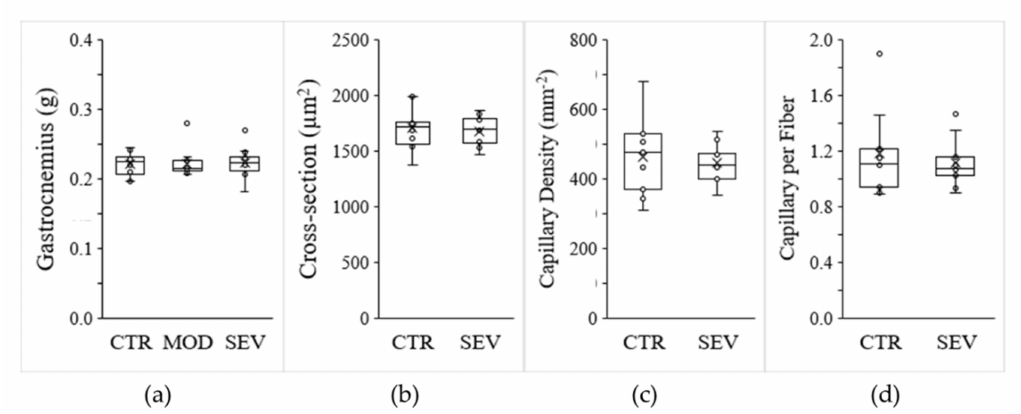
Figure 3. Mg 2+ -deficient diet and muscle characteristics. Mice were fed either a control (CTR), a mildly (MOD), or a severely (SEV) Mg 2+ -deficient diet: ( a ) gastrocnemius muscle weight; ( b ) muscle fiber cross-sectional area; ( c ) muscle capillary density; ( d ) number of capillaries per fiber. Data (N = 12 per group) are presented as box-and-whisker